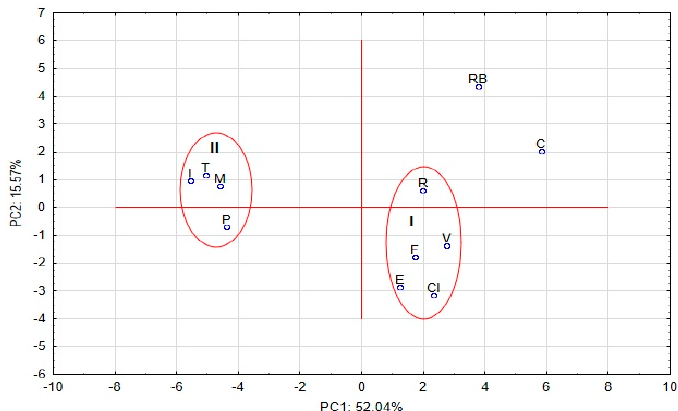
Figure 5. The score plots based on the autoscaled lipophicility results for analyzed compounds, studied picturing the objects in a two-dimensional space.